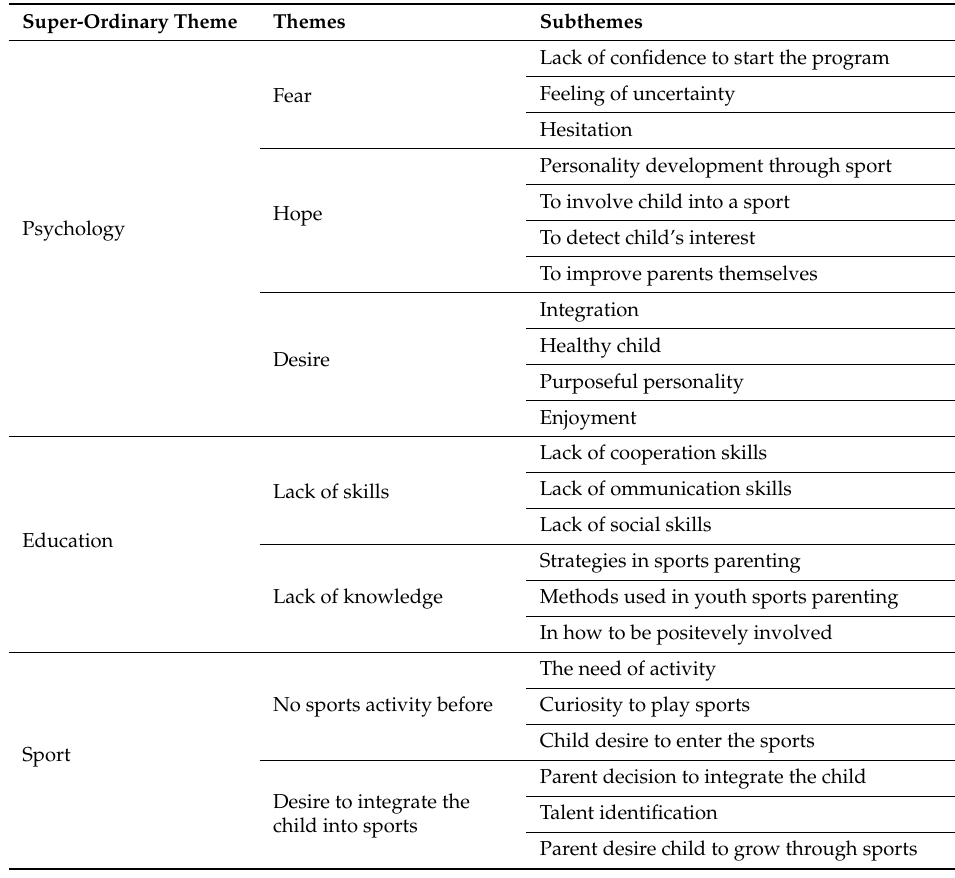
Table 1. Before the intervention.